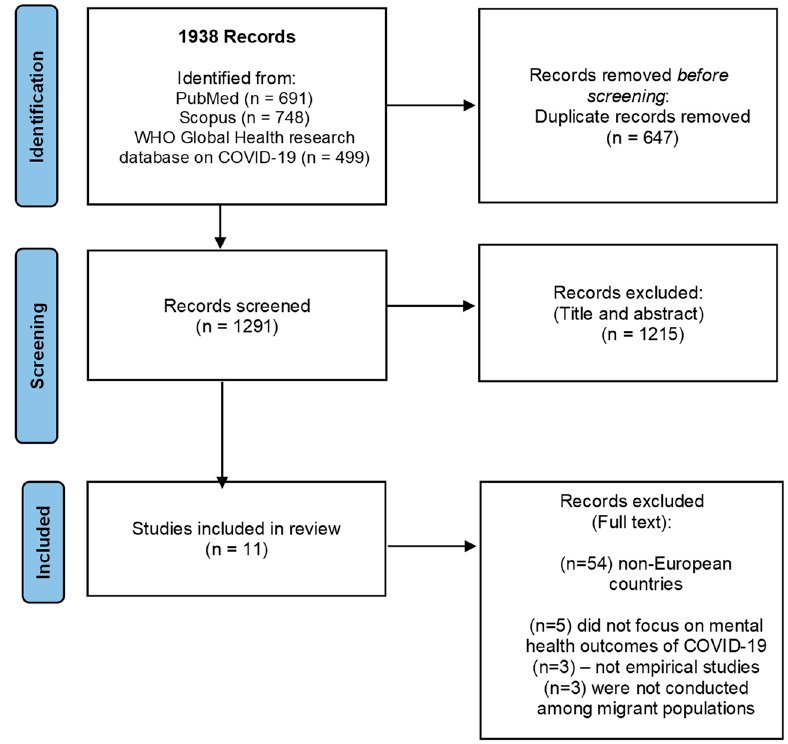
Figure 1. PRISMA 2020 flow diagram.